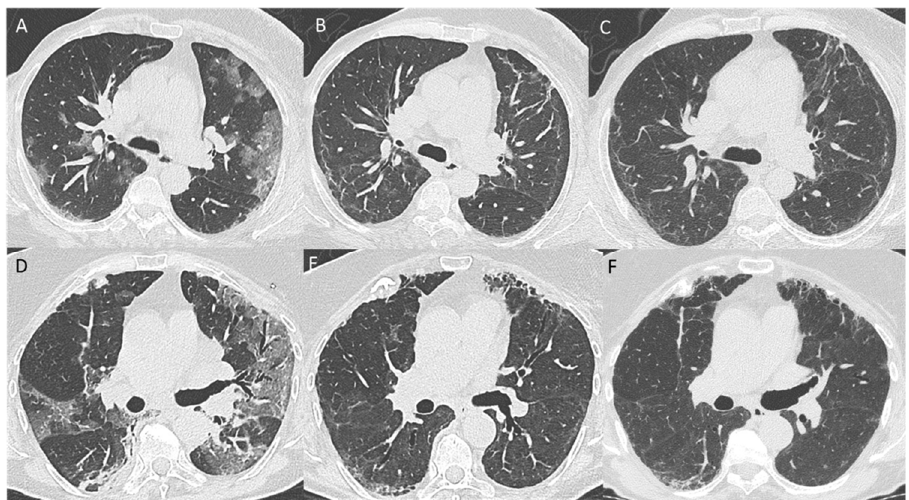
Figure 2. Baseline ( A ), 6-month follow-up ( B ), and 12-month follow-up ( C ) axial CT images showing the evolution of organizing pneumonia (OP) features towards residual non-fibrotic abnormalities resembling NSIP. Baseline ( D ), 6-month follow up ( E ), and 12-month follow-up ( F ) axial CT scans, showing patchy ground glass opacities (GGO) that are progressively replaced by reticular abnormalities and mild traction bronchiectasis resembling a fibrotic NSIP pattern.